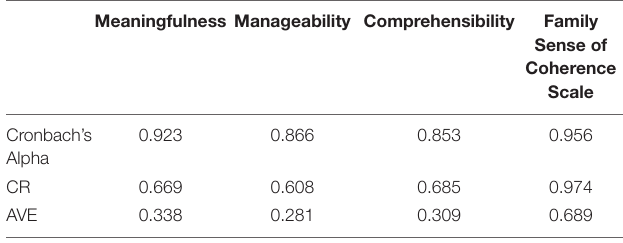
TABLE 5 | Average variance extracted and reliability analysis for FSOC Scale and FSOC Scale